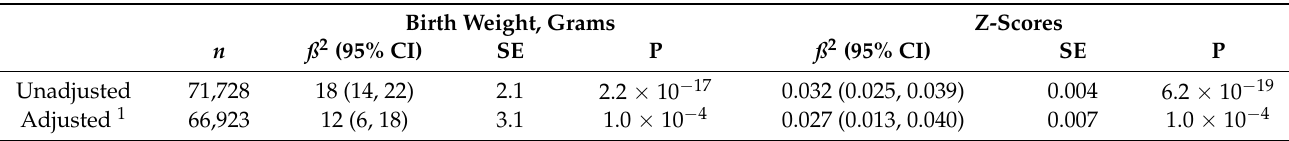
Table 2. Associations between maternal dietary selenium intake and birth weight in 71,728 women from the Norwegian Mother, Father and Child Cohort study.